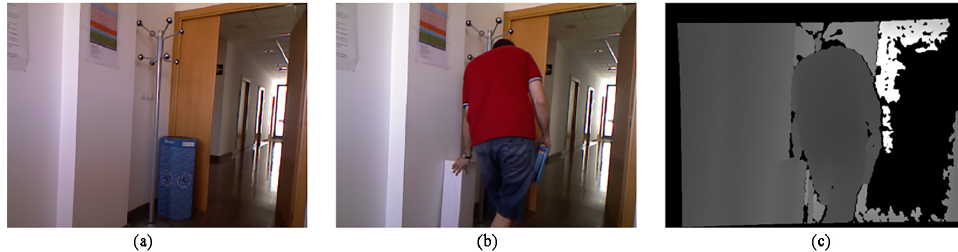
Figure 10. Sampling map of Experimental Scenario Two: ( a ) Background image; ( b ) Color image of the 258th frame; ( c ) Depth image of the 258th frame.